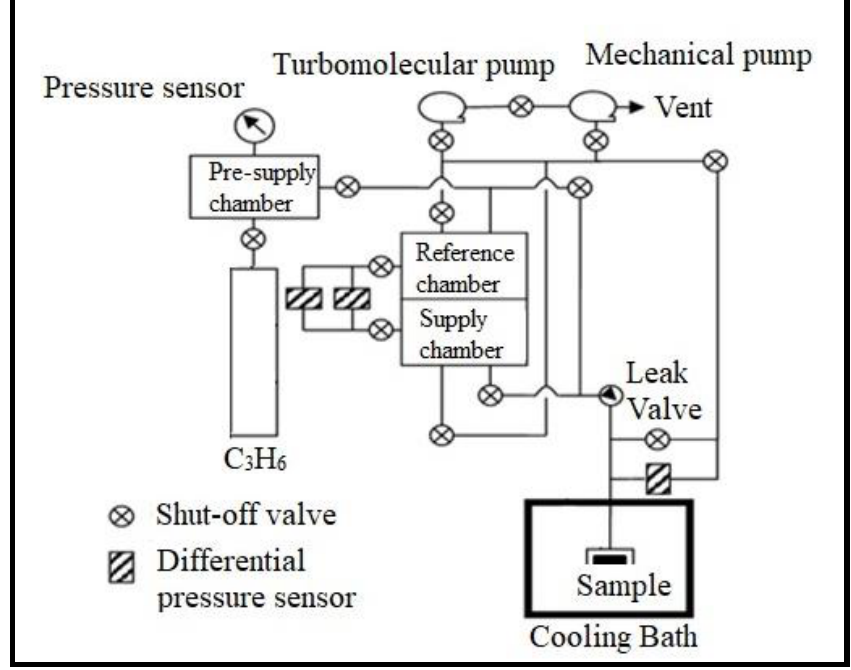
Figure 1. Schematic of a vacuum adsorption apparatus.